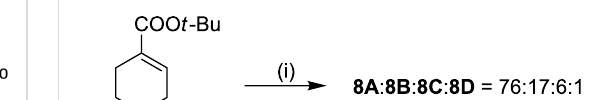
When N -benzyl- N - α -methylbenzylamine was applied as a chiral nucleophile in the conjugate addition, the steric effect of the α -methyl substituent could be investigated. The addition was proven highly stereoselective (de > 99%), based on the 1 H NMR data of the crude product and cis -amino ester 11 as a single product was obtained in gram-scale quantities and high